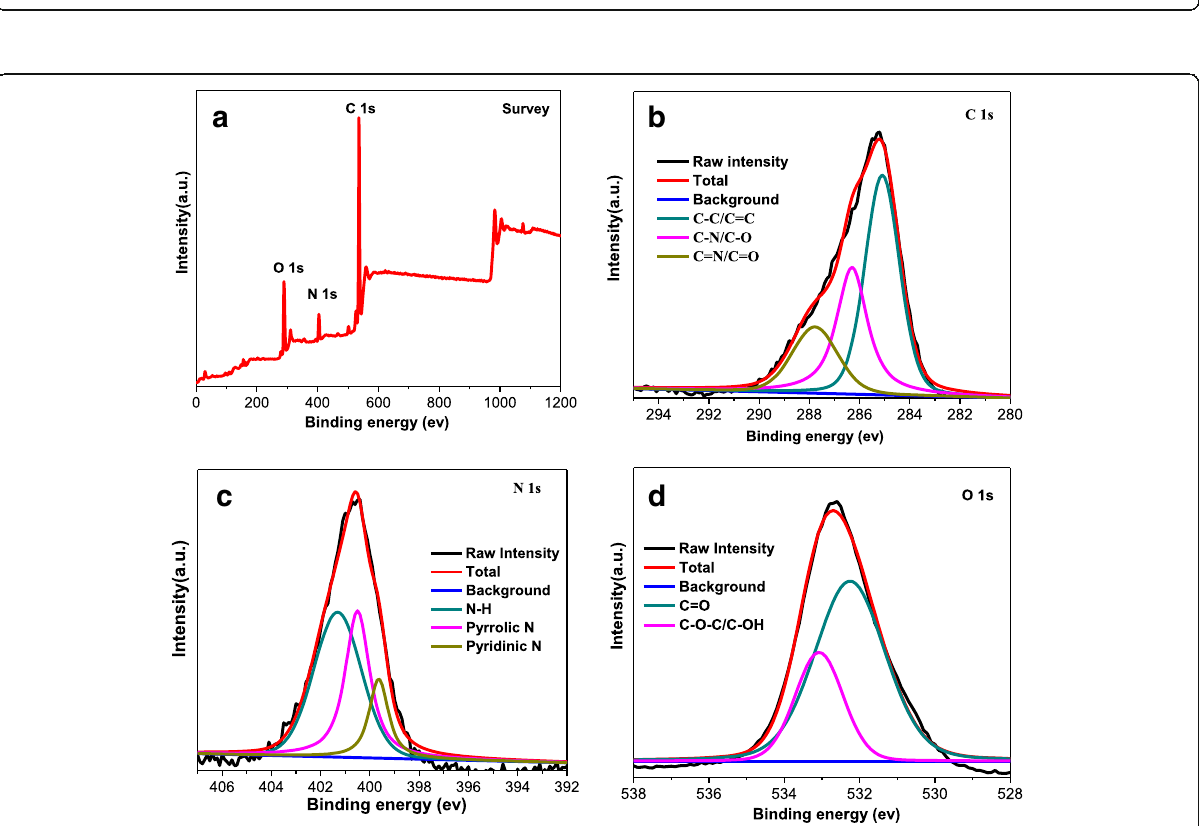
Fig. 3 XPS survey spectrum ( a ), and C 1s ( b ), N 1s ( c ), and O 1s ( d ) high-resolution XPS spectra of